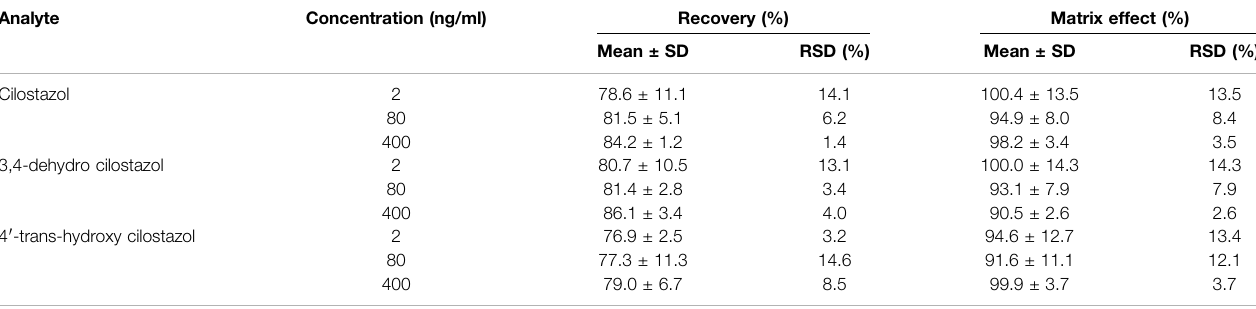
TABLE 5 | Stability results of cilostazol and its metabolites in plasma under different conditions ( n = 6). Analyte